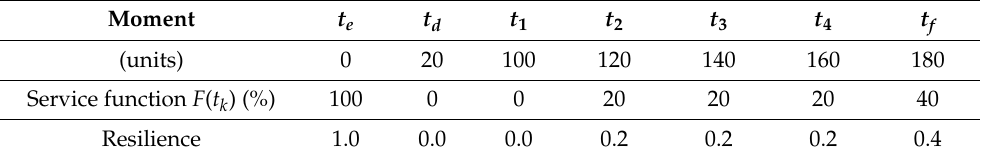
Table 2. Simulation of a possible security breach—Location